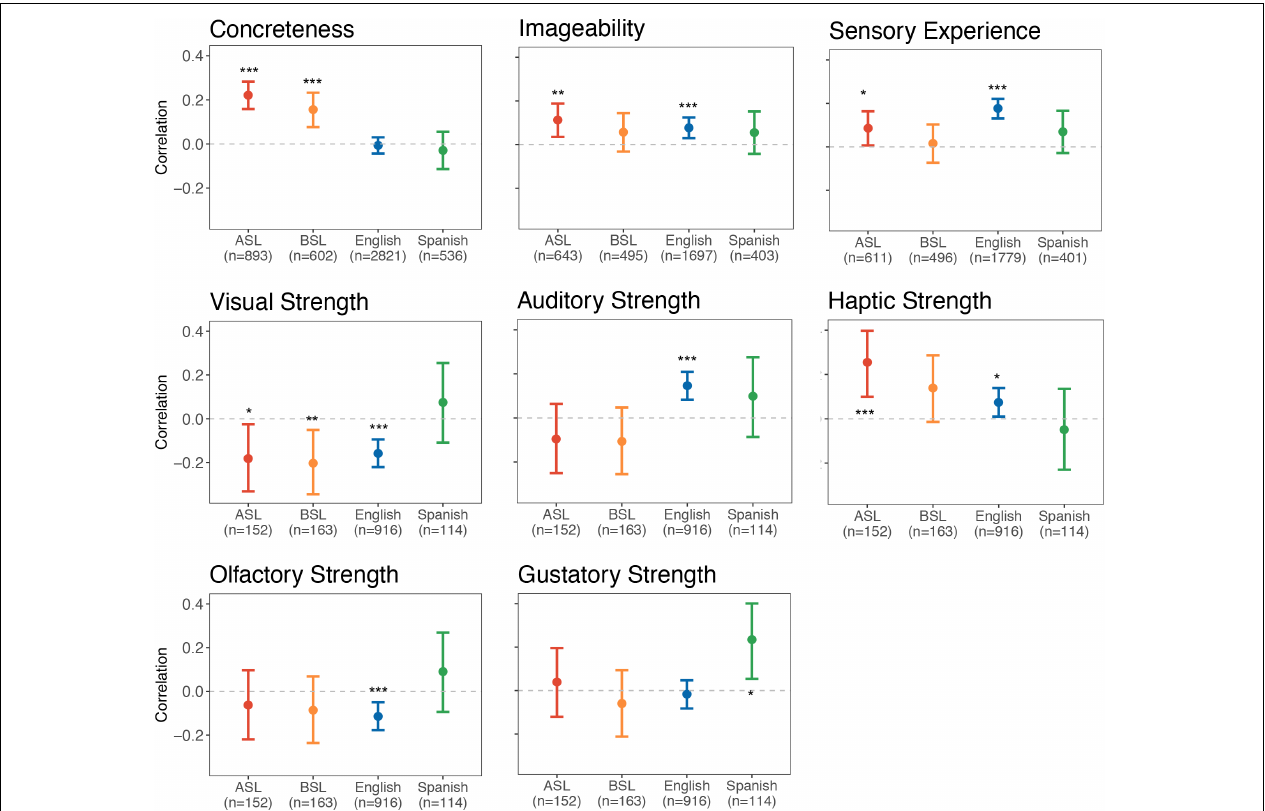
FIGURE 1 | Pearson correlation coefficients between iconicity ratings and ratings of semantic properties. Error bars show 95% confidence interval. Below each language, n indicates the number of signs or words for which there were ratings. Stars indicate the significance of the correlation. ∗∗∗ p < 0.001, ∗∗ p < 0.01, p ∗ <